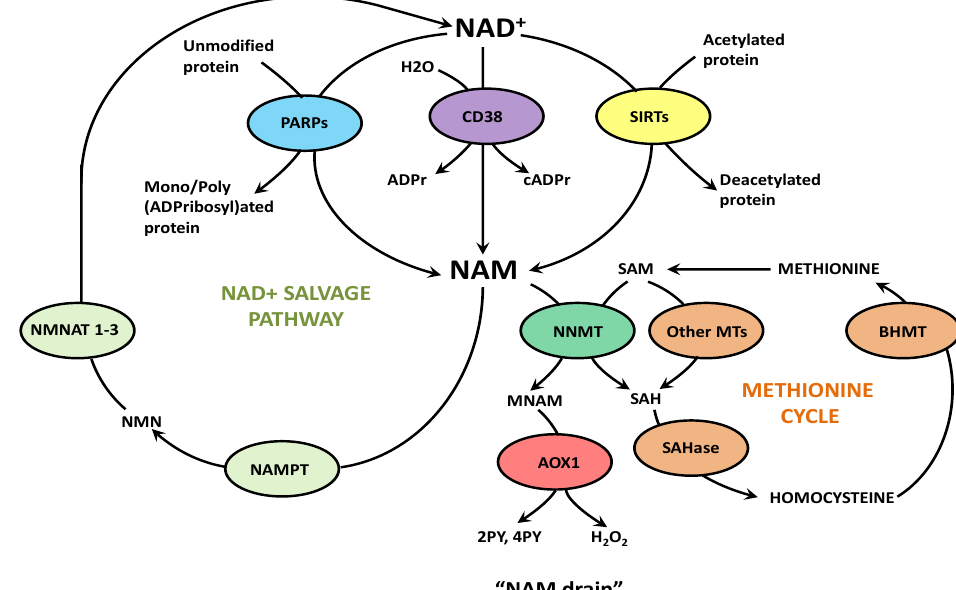
Figure 3. “NAM drain” concomitantly affects NAD + salvage pathway and methionine cycle. Ex- cessive nicotinamide (NAM) clearance by its nicotinamide N-methyltransferase (NNMT)-mediated methylation excludes NAM from the salvage pathway and consumes methyl units from S-adenosyl methionine (SAM) to generate N1-methylnicotinamide and S-adenosyl homocysteine (SAH). Enzyme S-adenosyl-L-homocysteine hydrolase (SAHase) converts SAH into homocysteine (Hcy). Conditions of high NAD + consumption and liberation of NAM, as well as excessive dietary intake of vitamin B3, promote “NAM drain”-mediated clearance of surplus NAM. This process stalls NAD + synthesis in the salvage pathway, decreases methylation potential of the cell and augments the generation of (Hcy).